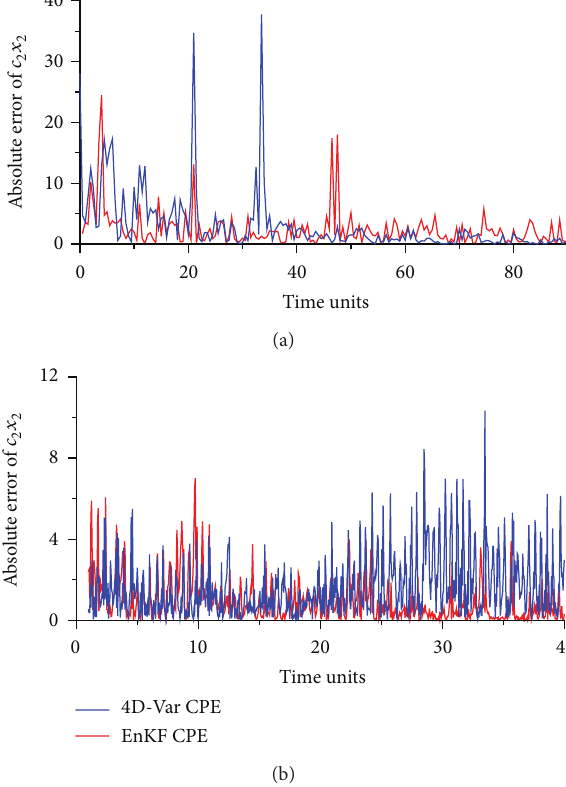
Figure 12: Time series of absolute errors of 𝑐 1 𝑤 for 4D-Var CPE (blue) with MTW being 50 time steps and EnKF CPE (red) with 10- ensemble size in EXP-4. Here, the observational interval is 50 time steps.